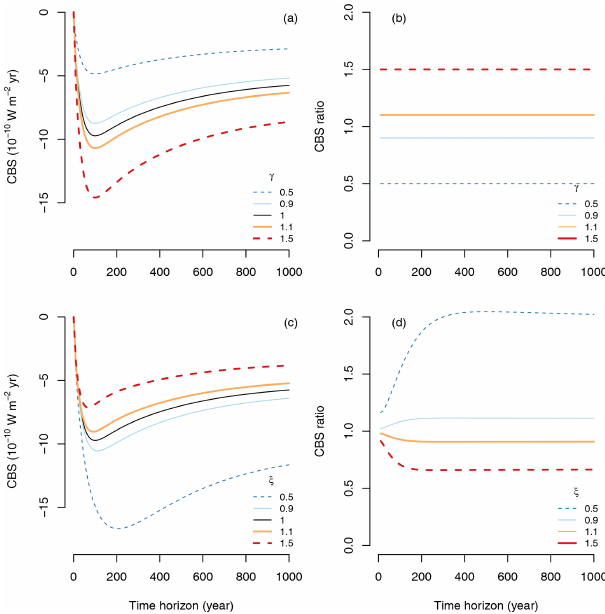
Figure 7. Different carbon management strategies and their effect on the CS and CS 1 . Management to increase or decrease carbon inputs in the vector u by specific proportions γ is shown in panel (a) and (b) . Management to increase or decrease process rates in the matrix B by a proportion ξ is shown in panels (c) and (d) . Since CS 1 quantifies carbon sequestration of one unit of carbon, management of the amount of carbon inputs does not modify CS 1 in panel (b) , and all lines overlap.